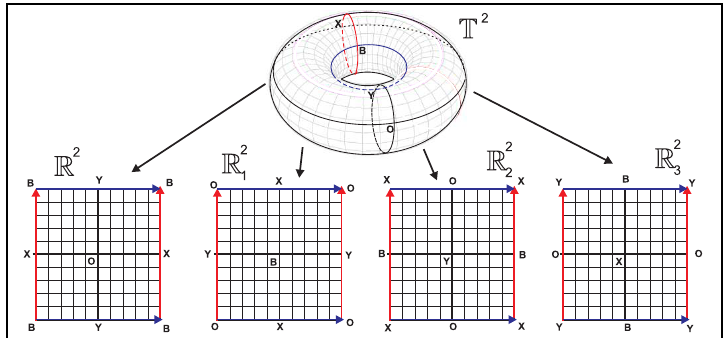
Figure 4. Torus T 2 and planes R 2 , R 2 1 , R 2 2 , R 2 3